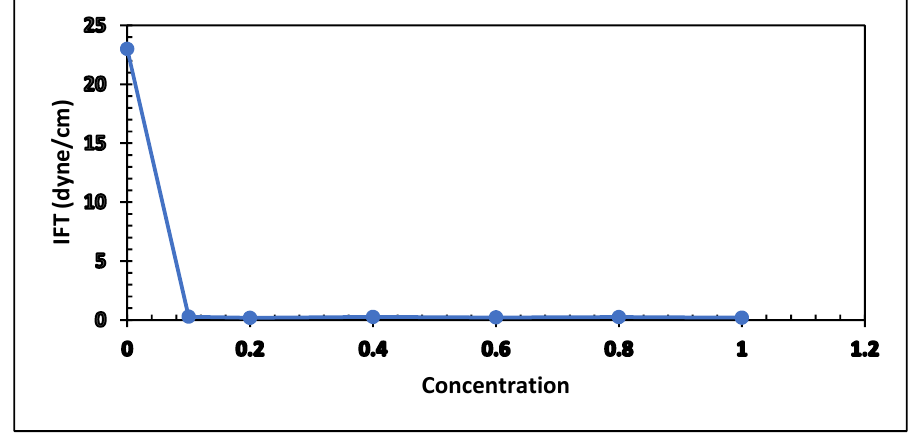
Figure 10. IFT measurements as a function of formic acid concentration. Table 4. APG surfactant and different concentration of formic